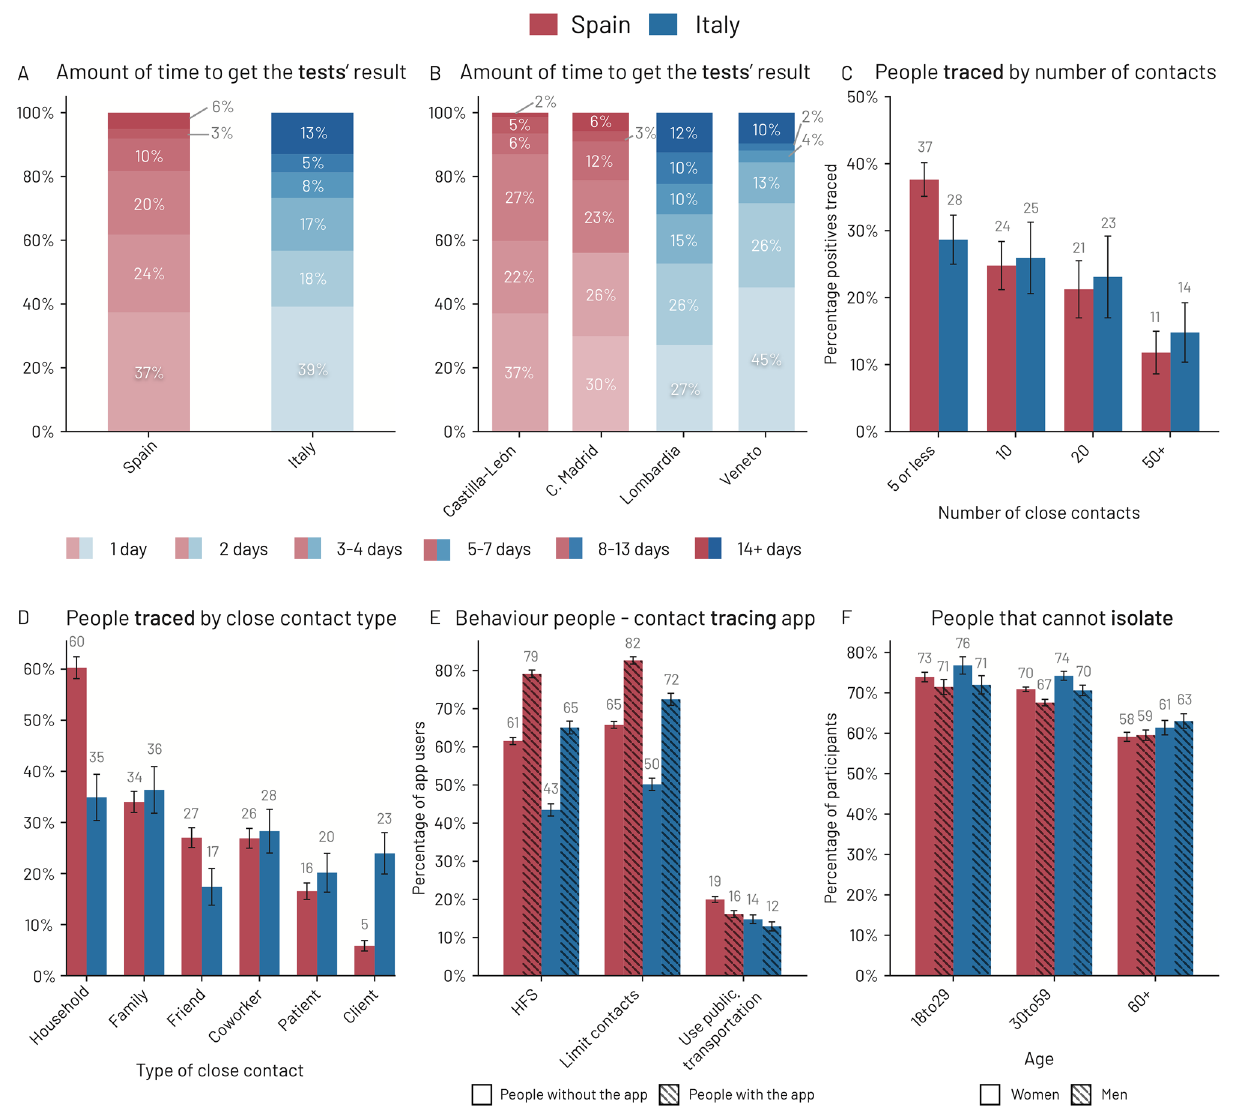
Figure 1. The test-trace-isolate (TTI) control strategy during the Phase I— new normality in Spain (red) and Italy (blue). (A) Amount of time to get the results of a COVID-19 test in Spain and Italy; (B) amount of time to get the results of a COVID-19 test in two exemplar regions for Spain and in two exemplar regions for Italy; (C) percentage of close contacts that were contact-traced by the health authority in Spain and Italy. The majority of respondents who had a close contact with a positive case report were not contacted by the health authority. (D) Percentage of close contacts traced for different categories of contacts in Spain and Italy. Spain focused the tracing activity within the household, where 60% of the people reported having been contact traced. (E) Protection measures adopted by people in Spain and Italy, divided by whether they installed the contact tracing app. Respondents who installed the contact tracing apps are more likely to report complying with the washing Hands, Face masks, making Space (HFS) recommendations, limit their close contacts and using less public transportations. (F) Percentage of people, in Spain and Italy, who report being unable to isolate effectively if needed. In plots (C–F) we report the 95% confidence in the respondents’ behaviours as a consequence of the implemented mitigation interventions deployed during the second wave phase. Effectiveness of the test, trace, and isolate control strategies in Spain and Italy. Test. The first TTI pillar entails promptly testing all suspected individuals with a coronavirus infection due to having had close contact with an confirmed infected case and/or exhibiting symptoms attributable to COVID-19. Figure 1A shows that 61% and 57% of respondents, in Spain and Italy respectively, reported receiving the test results within 48 hours from taking the test (Q24 answers a-b-d-f and Q24_3 in SI Table S1). However, we observe remarkable differences per administrative region. In the Autonomous Community of Madrid (Spain) 56% of tests took 48 h and 9% of tests took 8 days or more, while in Castilla-Leon (Spain) 59% of tests were